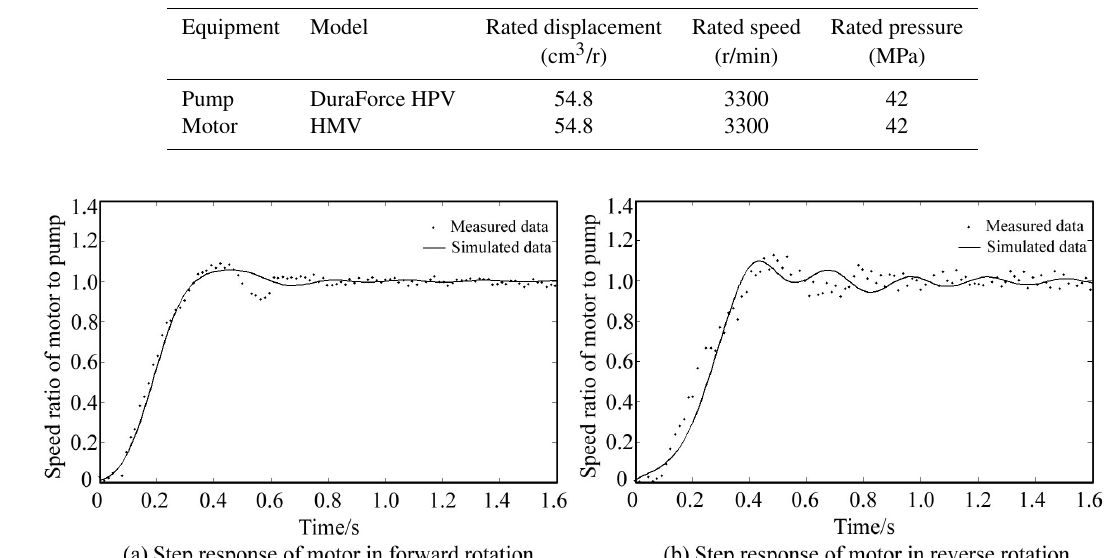
Figure 3. Step response of swash plate axial piston units.